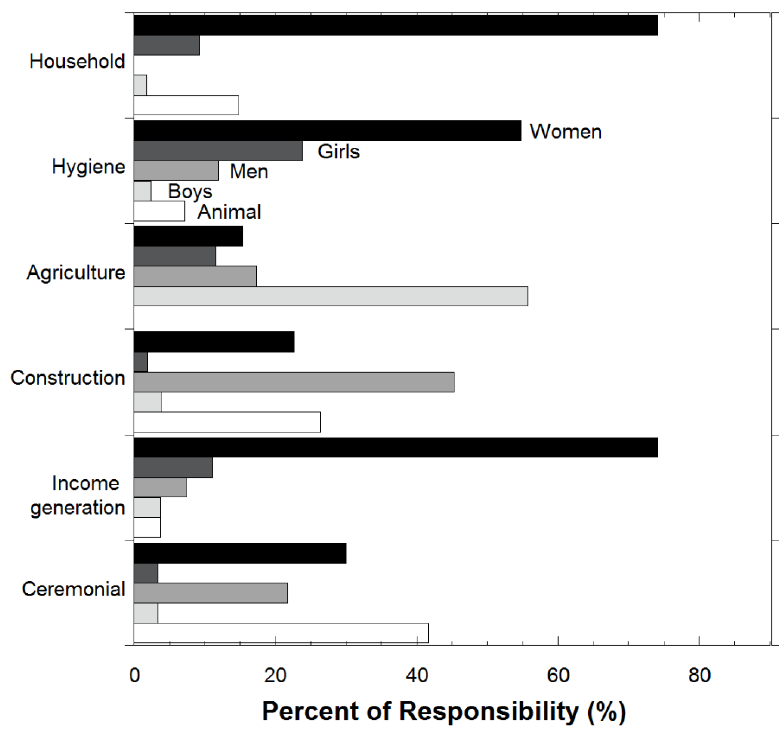
Figure 6. Division of water collection responsibilities by water use category.